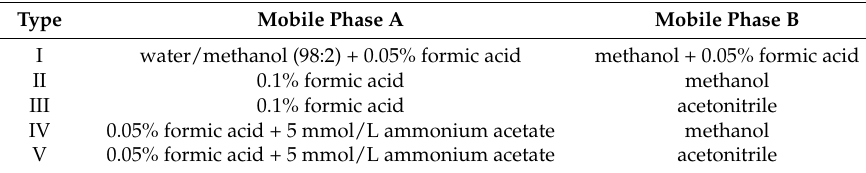
Table 1. The composition of mobile